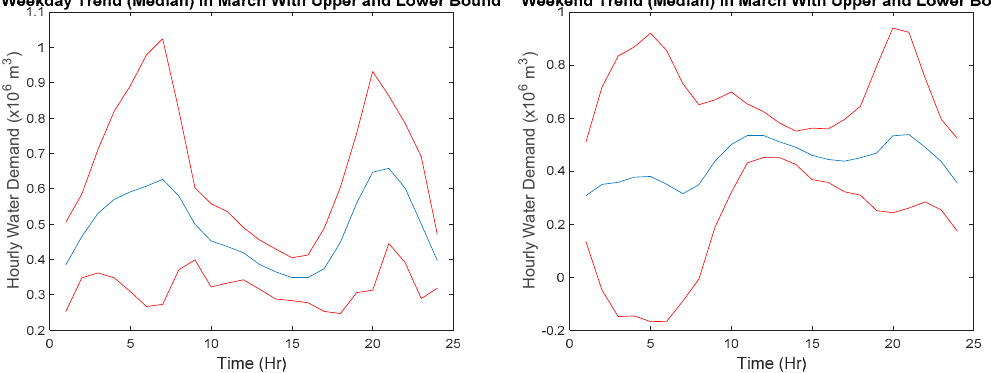
Figure 8. Median of extracted weekday and weekend water demand trend with upper and lower bound.